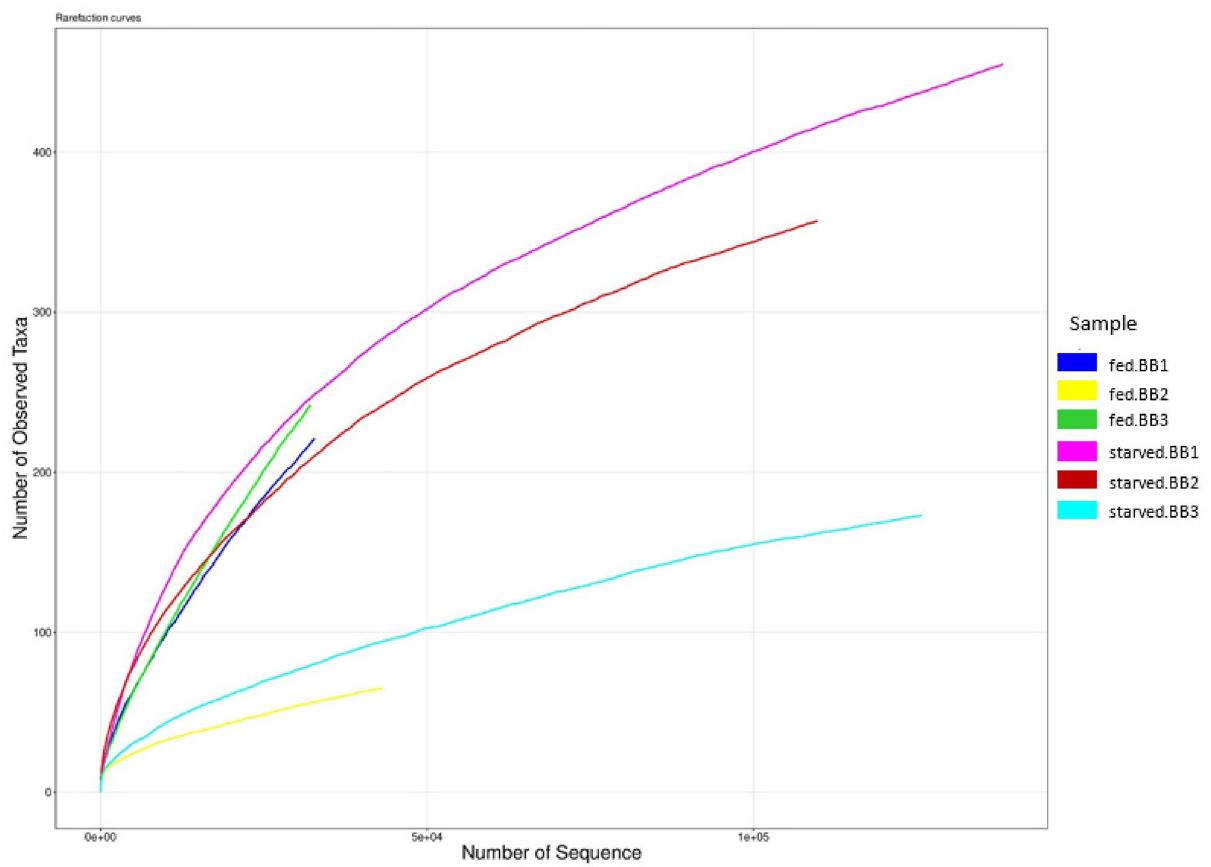
Figure 2. Rarefaction curves of the three samples, fed.BB1 (blue line), fed.BB2 (yellow line) and fed.BB3 (green line) from blood-fed bed bugs and three samples, BB1 (purple line), BB2 (red line) and BB3 (turquoise line) from starved bed bugs.